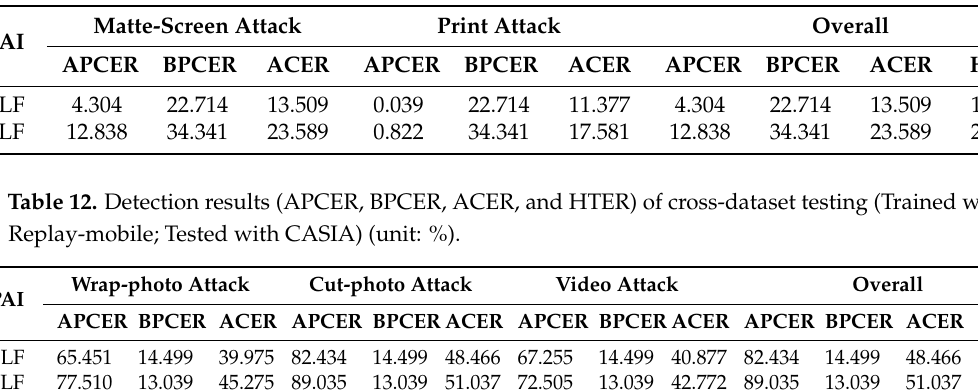
Table 11. Detection results (APCER, BPCER, ACER, and HTER) of cross-dataset testing (Trained with CASIA; Tested with Replay-mobile) (unit: %).